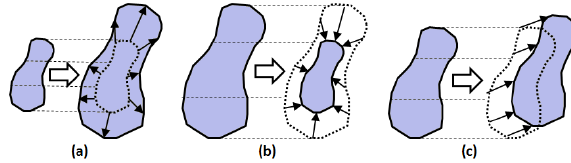
Figure 3. Change pattern: (a) Growth (expansion) , (b) Shrinkage (contraction) , (c)